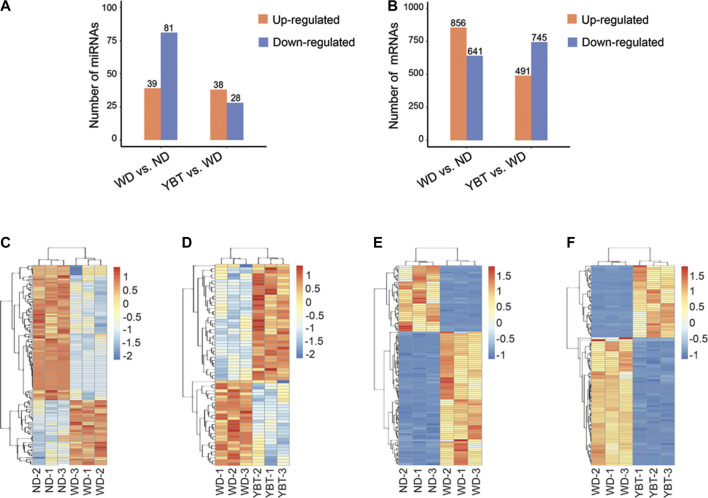
Global analysis of DEmiRNAs and DEmRNAs of WD vs. ND group or Yiqi-Bushen-Tiaozhi (YBT) vs. WD group. (A,B). The bar-charts showing the numbers of up-regulated and down-regulated DEmiRNAs or DEmRNAs. (C,D). The heatmaps of DEmiRNA expression profiles (p < 0.05). (E,F). The heatmaps of DEmRNA expression profiles (p < 0.05, top 100). Scale bar denotes Z values. DEmiRNAs, significantly differentially expressed MicroRNAs; DEmRNAs, significantly differentially expressed mRNAs; ND, normal diet for 16-weeks; WD, Western diet for 16-weeks; YBT, Western diet for 16 weeks combined with YBT treatment for 12 weeks.